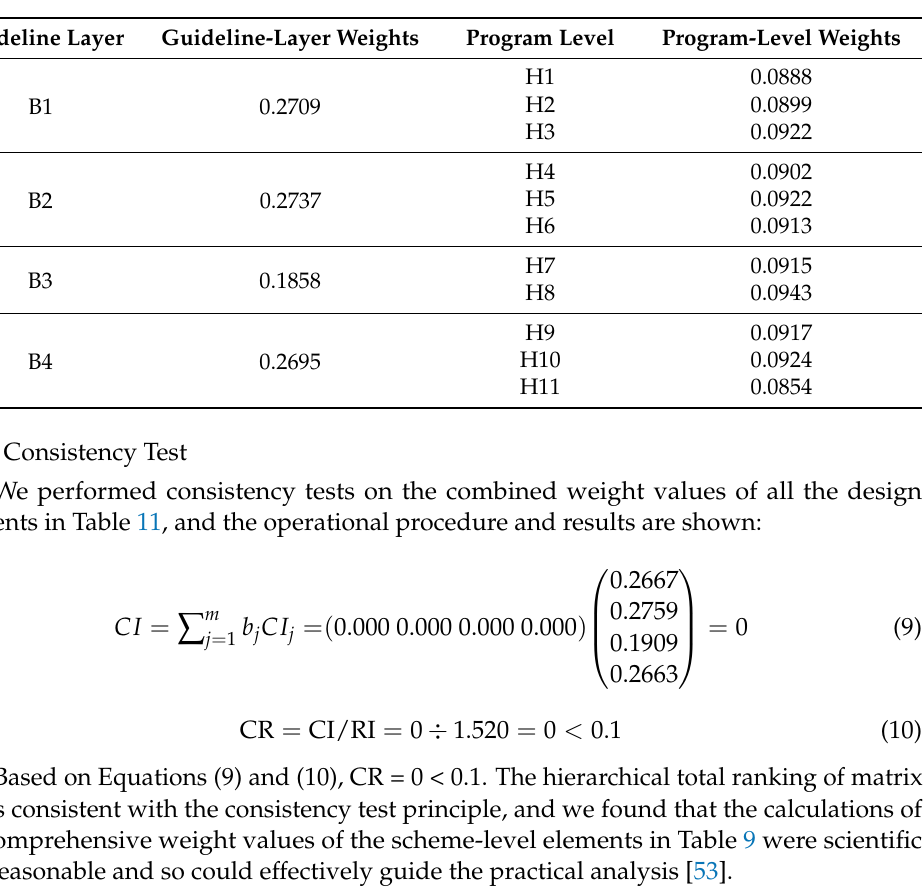
Table 11. Comprehensive weight values of criterion-layer